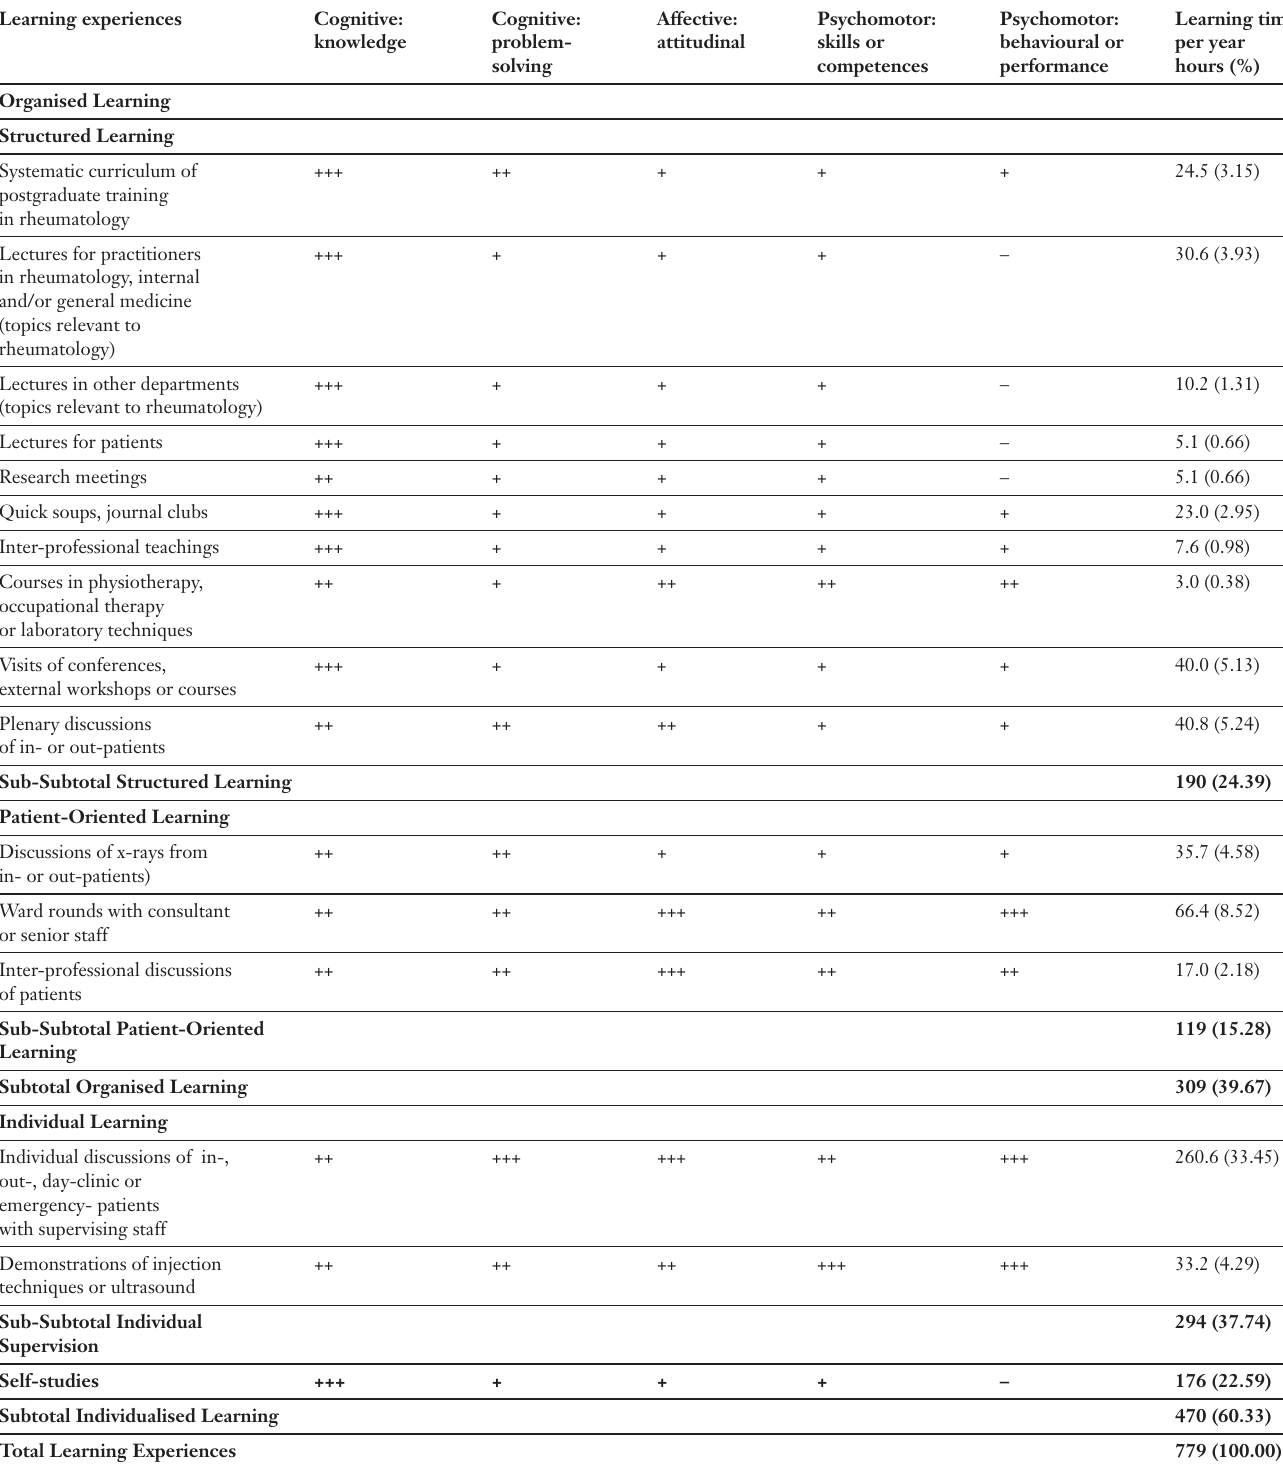
Analysis of the present educational strategies with respect to cognitive, affective and psychomotor